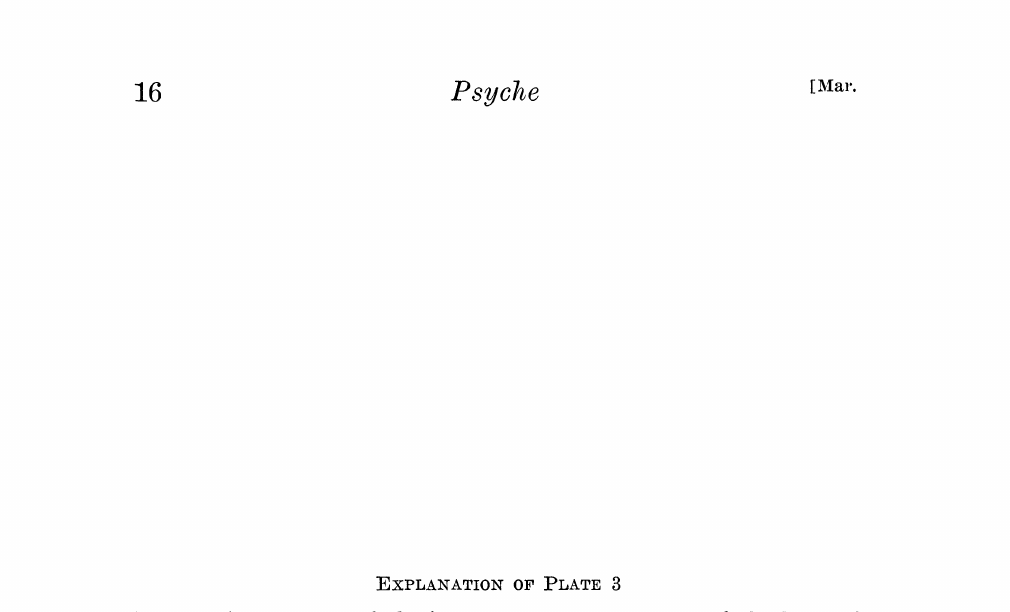
EXPLAATIO OF =)LATE 3 Arrangement of the integumentary sense organs of the larva of Fig. 6. lhipicephalus sanguineus Latr.: Fd, fovem dorsales; Sa, sensilla auriformia; Sh, sensilla hastiformia; Ss, sensilla sagittiformia. Arrangement of the integumentary sense organs of the larva of Fig. 7. Boophilus calcaratus Birula: Fd, fovem dorsales; Sa, sensilla auri. formiu; Sh, sensilla hastiformia; Ss, sensilla